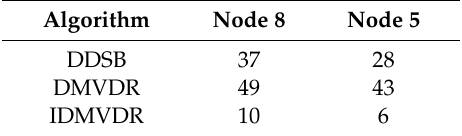
Table 3. The number of iterations when converging in the WASN with N d = 15. Algorithm